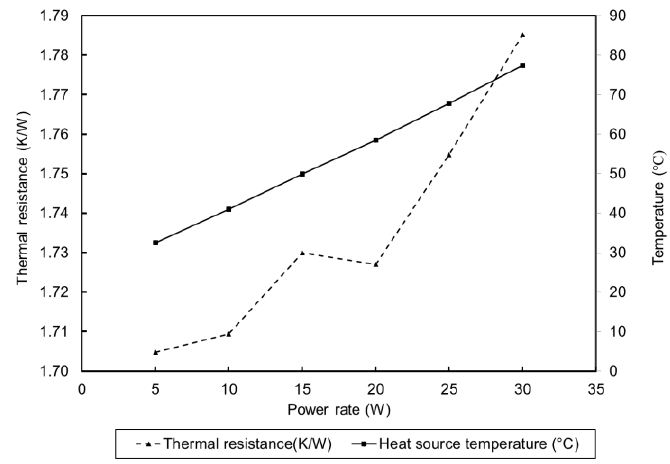
Figure 14. Effects of number of layers on the thermal resistance and heat source temperature of 30 mL/min HTF flow rate and 15 W power rate.